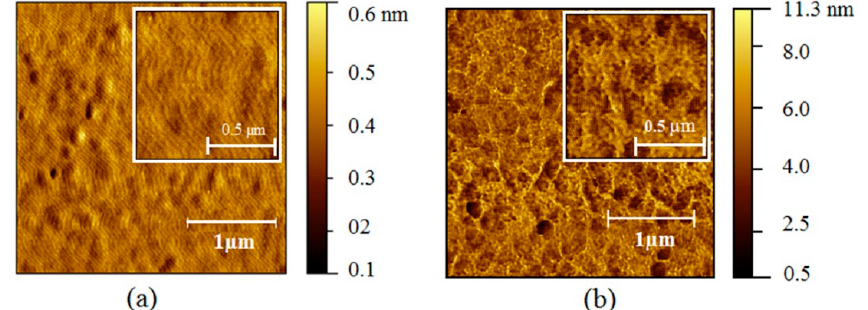
Figure 4. Atomic force microscopy (AFM) images (1 µm) of ( a ) non-treated and ( b ) thermally treated gas sensors .